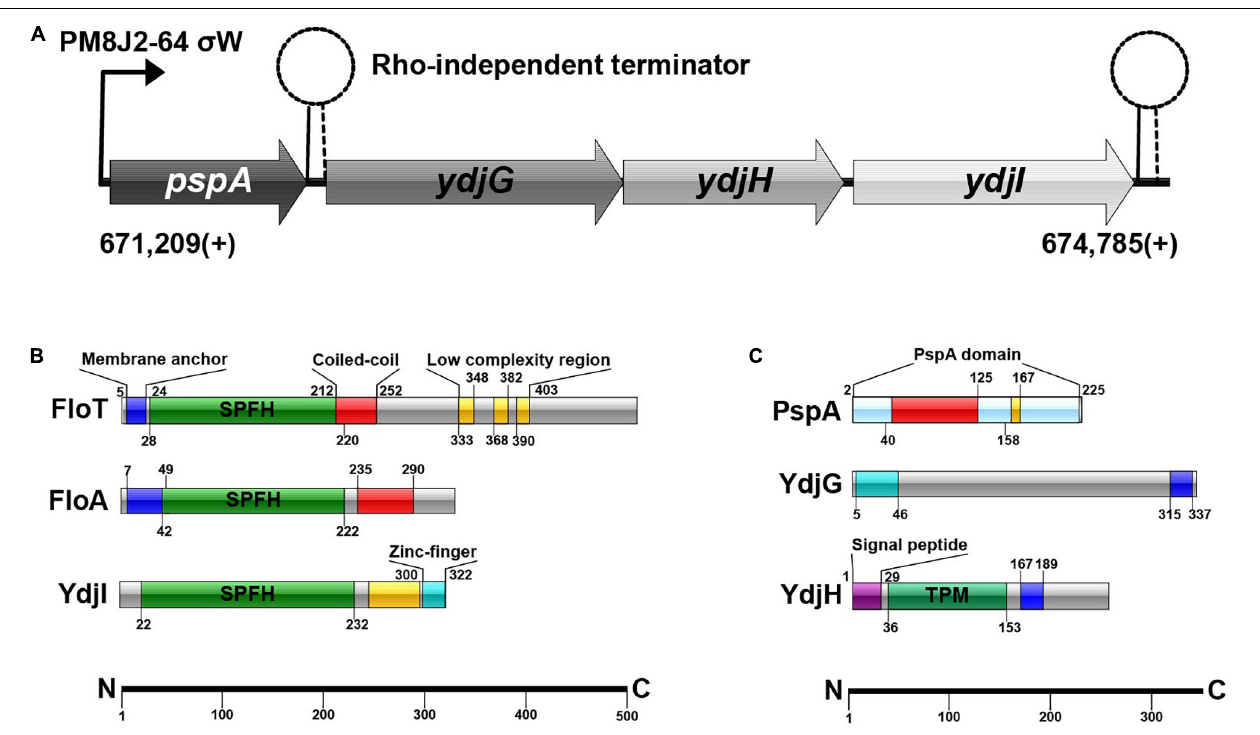
FIGURE 1 | (A) Schematic overview of the pspA - ydj -operon. σ W -dependent promotor PM8J2-64 starts transcription at 671,209(+); transcription starts with pspA , continuing with ydjG , ydjH and subsequently ydjI . (B) SPFH-proteins in B. subtilis and their domains. (C) Proteins of the ydj -operon and their protein-domains.